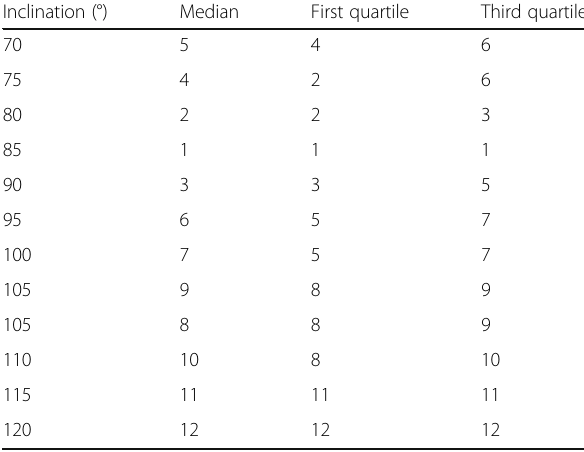
Table 1 Attractiveness rating of images by